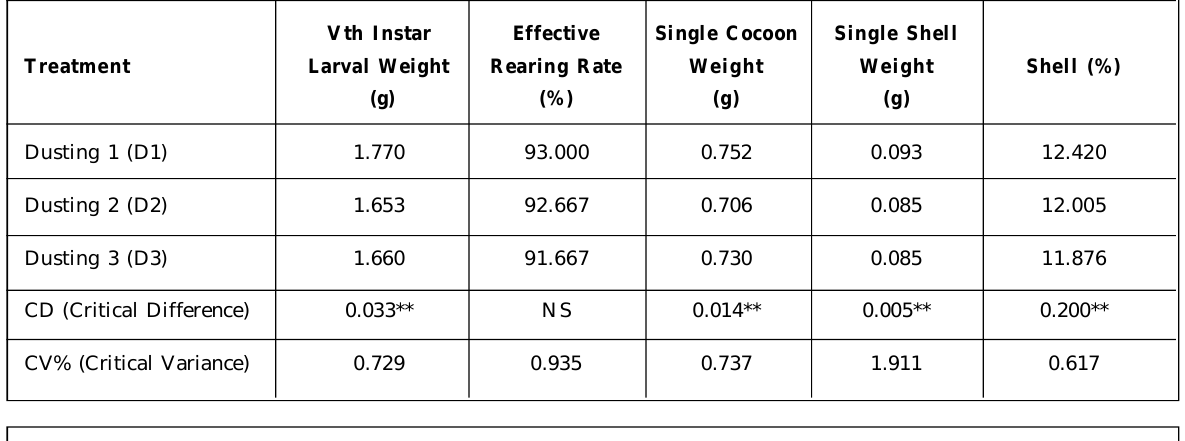
Table 6: Rearing - III: Economic parameters after challenge with Bm NPV during Aug- Sep, 2017-20 Vth Instar Effective Single Cocoon Single Shell Treatment Larval